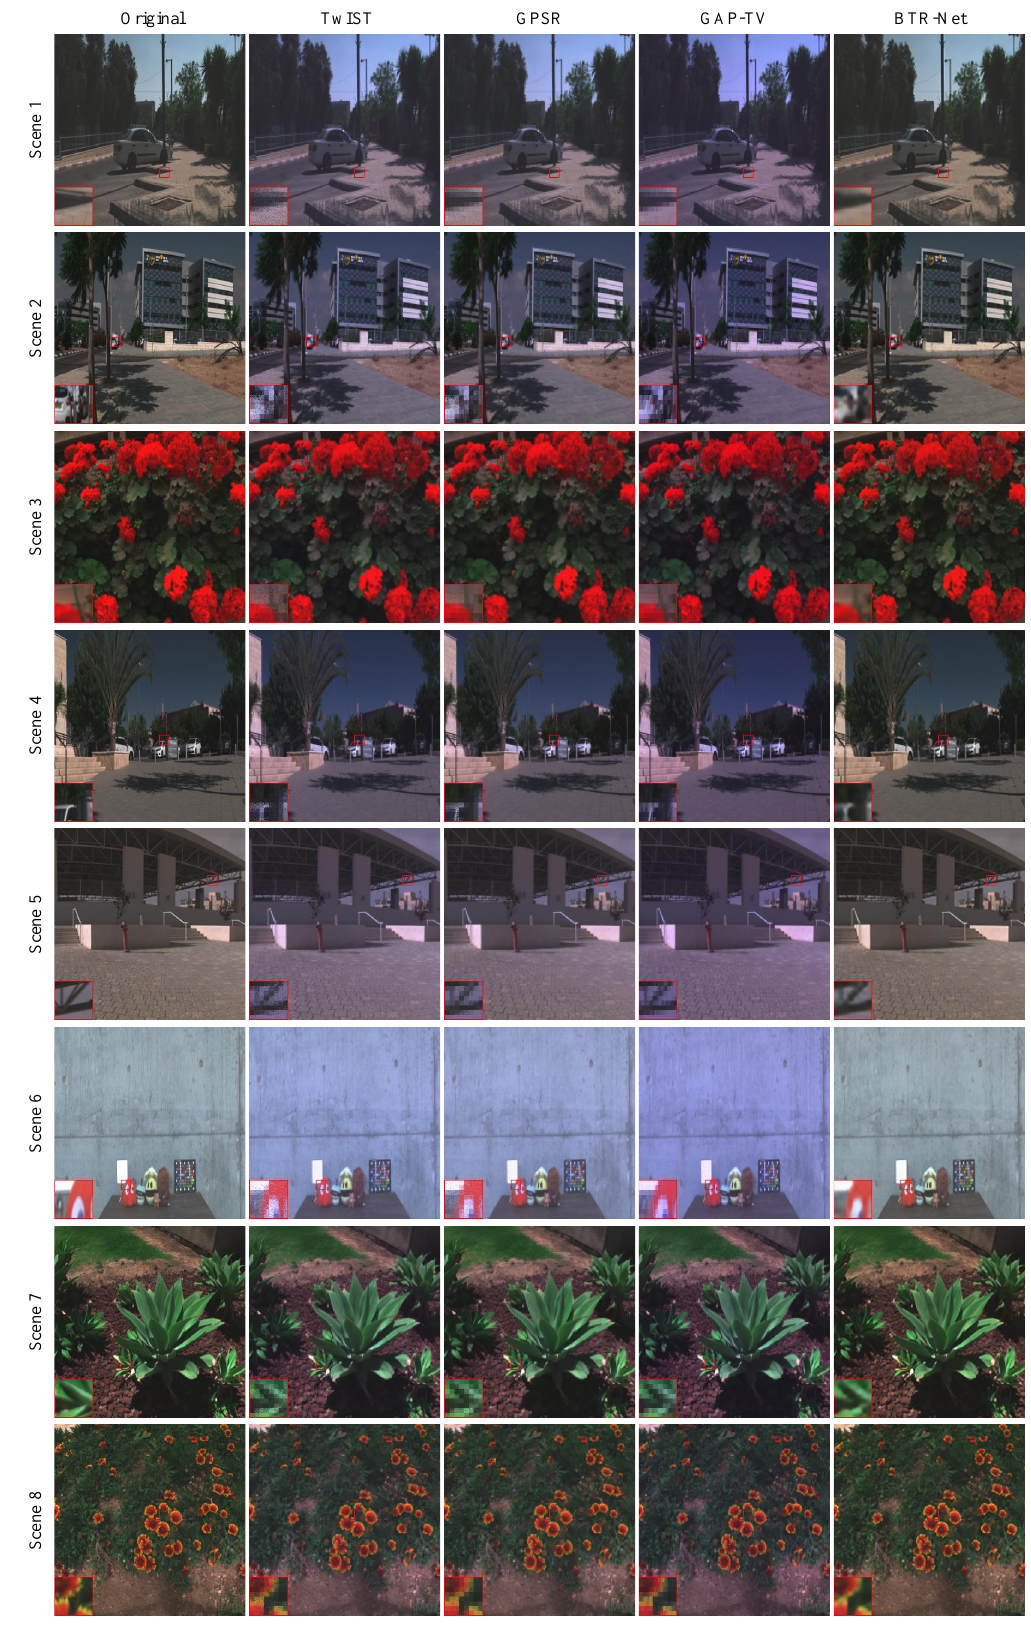
Figure 4. RGB projections of the reconstructed